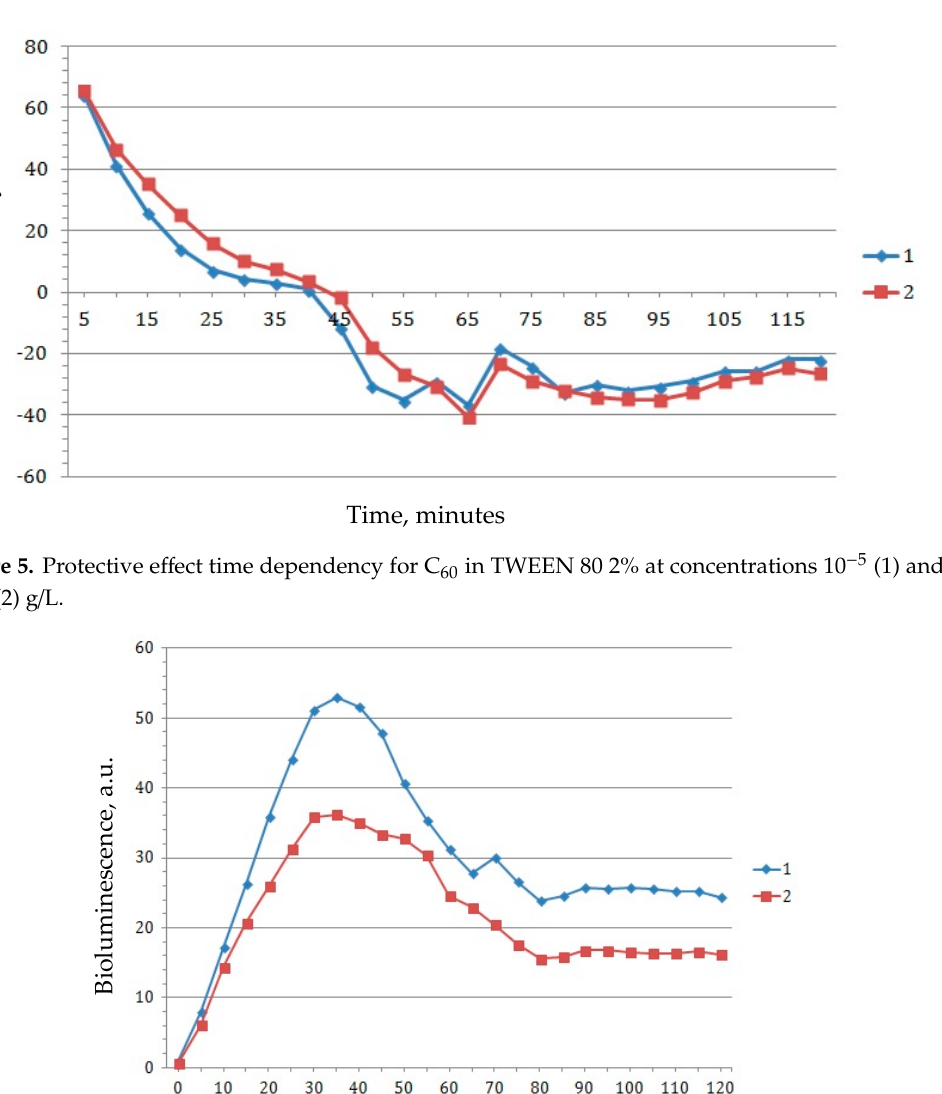
Figure 6. Increase of luminescence induction by hydrogen peroxide with and without the preliminary addition of TWEEN 80 2%. 1: Induction of luminescence by hydrogen peroxide in cells in which TWEEN 80 was previously added 2%; 2: Induction of luminescence by hydrogen peroxide without TWEEN 80.